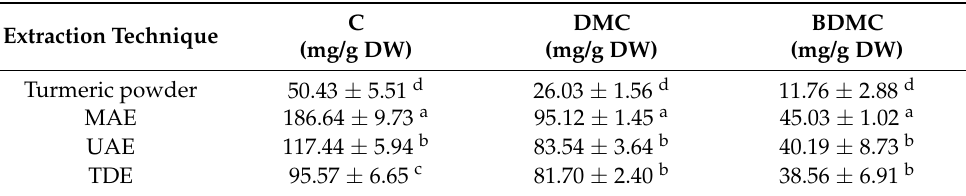
Table 2. Curcuminoid content of turmeric powder and turmeric powder extracted by different extraction techniques 1 . Extraction